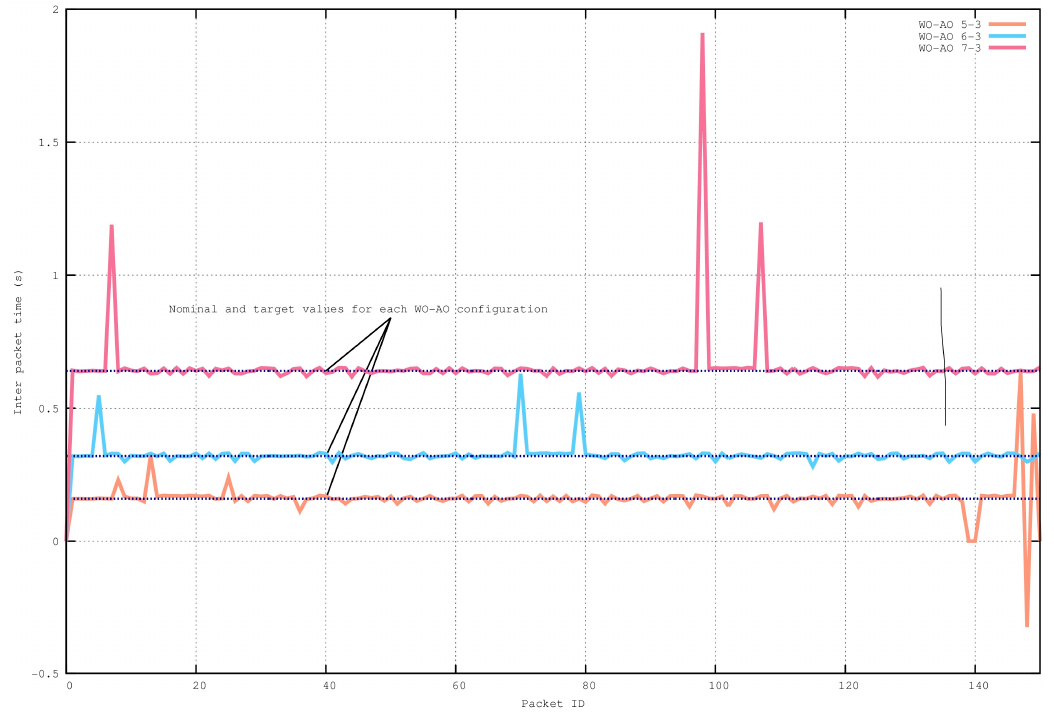
Figure 10. Inter-packet arrival times for a 6 × 6 network.